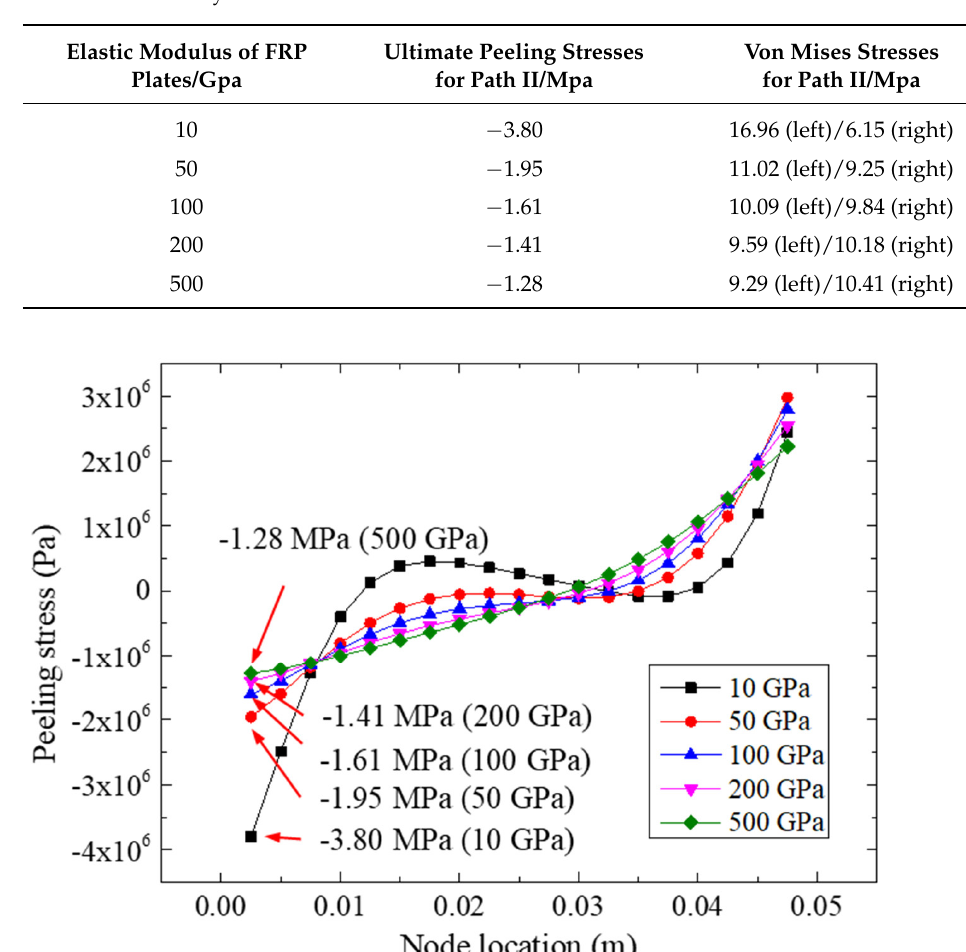
Figure 9. Peeling stresses on path II for different FRP elastic moduli.